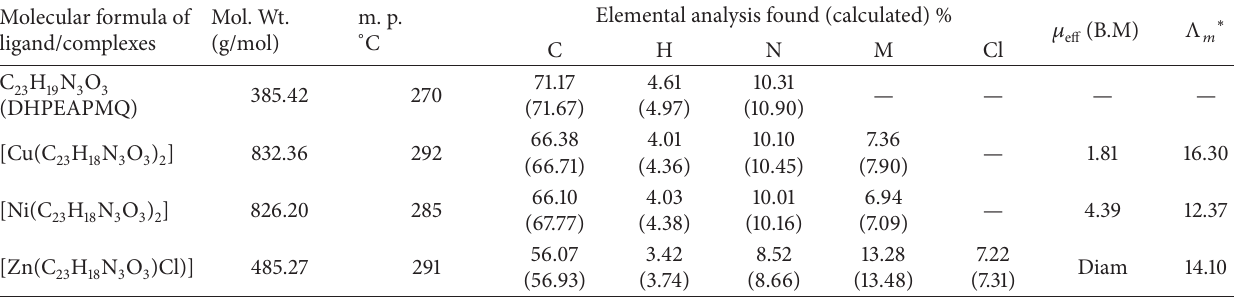
Table 1: Elemental analysis of physical and magnetic data of Schiff base (DHPEAPMQ) and its complexes. Molecular formula of